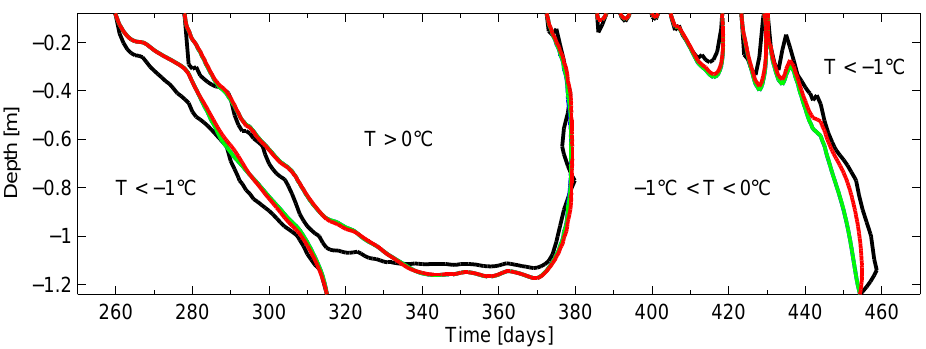
Fig. 9. Simulation results for the different scenarios at the Bayelva site in the summer of 1999. Shown are the 0 ◦ C and the − 1 ◦ C isotherms. The colors represent: black: measured data, blue: conduction with convection of liquid water and water vapor, scenario (i), green: conduction with convection of liquid water, scenario (ii), red: conduction with constant water distribution, scenario (iii). Blue (i) and green (ii) overlap almost entirely, so only the green line can be seen clearly.